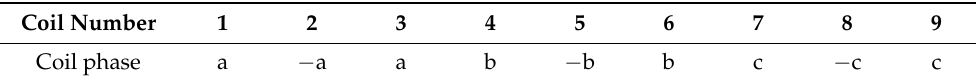
Figure 1. Double-sided stator single-rotor (DSSR) AFPM motor in 2D. Table 1. 9-slot 8/10-pole concentrated winding